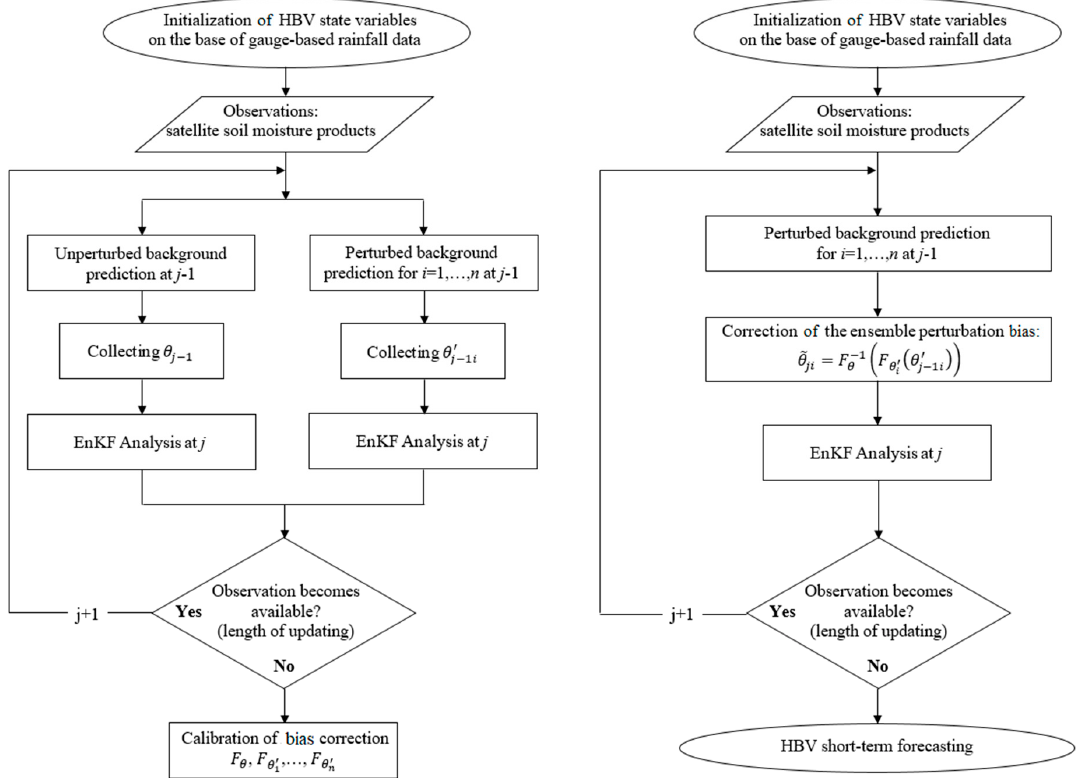
Figure 3. Data assimilation algorithm for updating the Hydrologiska Byråns Vattenbalansavdelning (HBV) model (EnKF-BC). Distribution fitting of the ensemble Kalman filter with bias correction (EnKF-BC) (left part) and assimilation procedure including the EnKF-BC (right part).